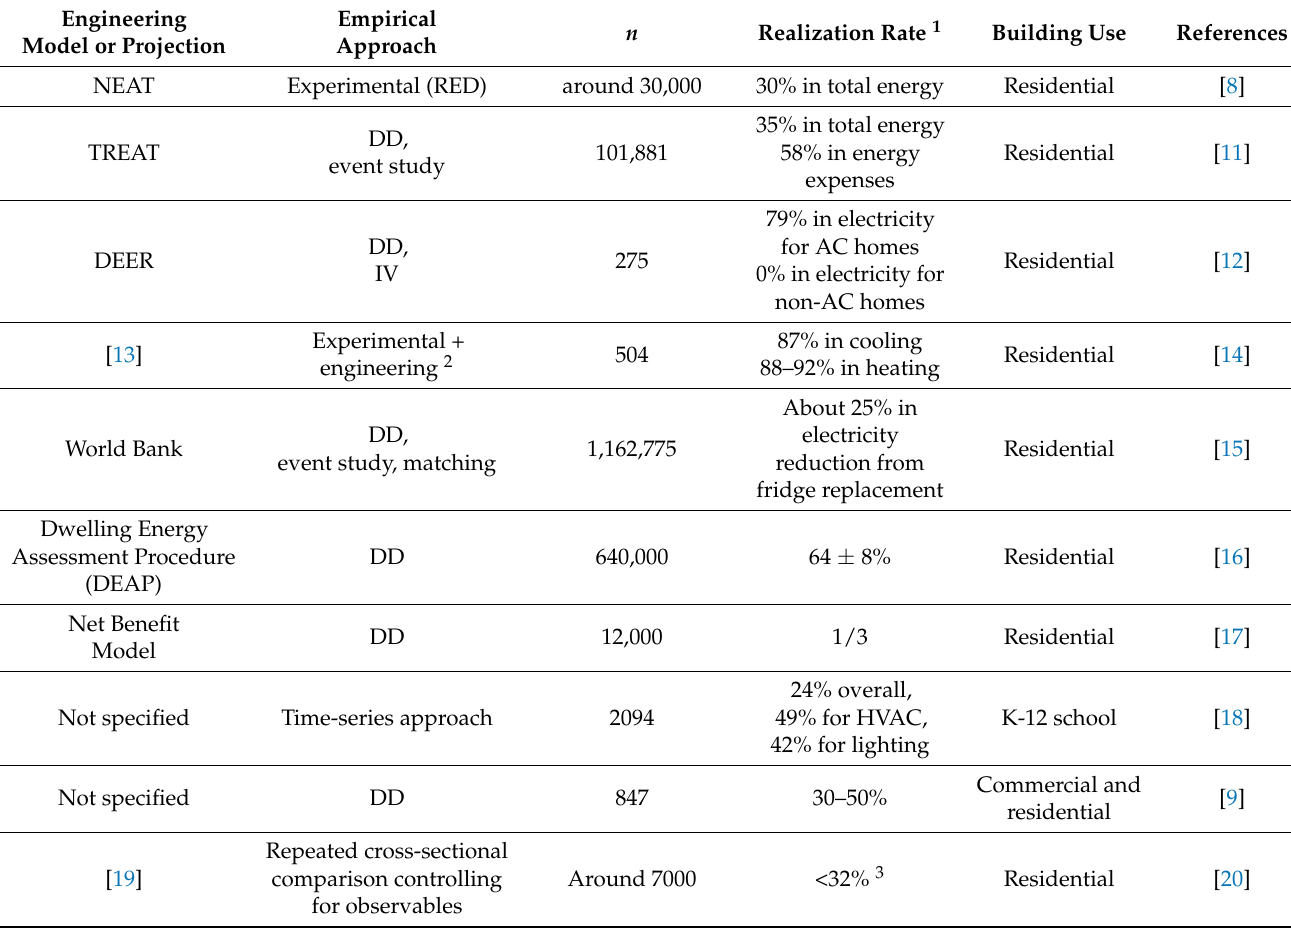
Table 1. Comparison between measured savings with empirical methods and predicted savings with simulation-based tools.